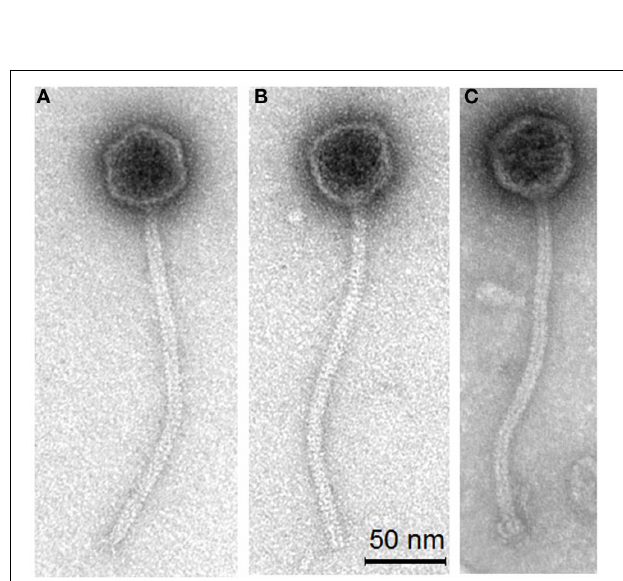
restriction fragments of λ -DNA are shown in the right margin. Agarose gel (C) of PCR-products generated from TP-J34 (lane 2) and TP-J34L (lane 3) DNA with primer pair D8 + und D12 + . Lane 1: DNA molecular weight marker IV (Roche Diagnostics GmbH, Mannheim, Germany), sizes are indicated in the left margin. Sizes of PCR products are shown in the right margin.